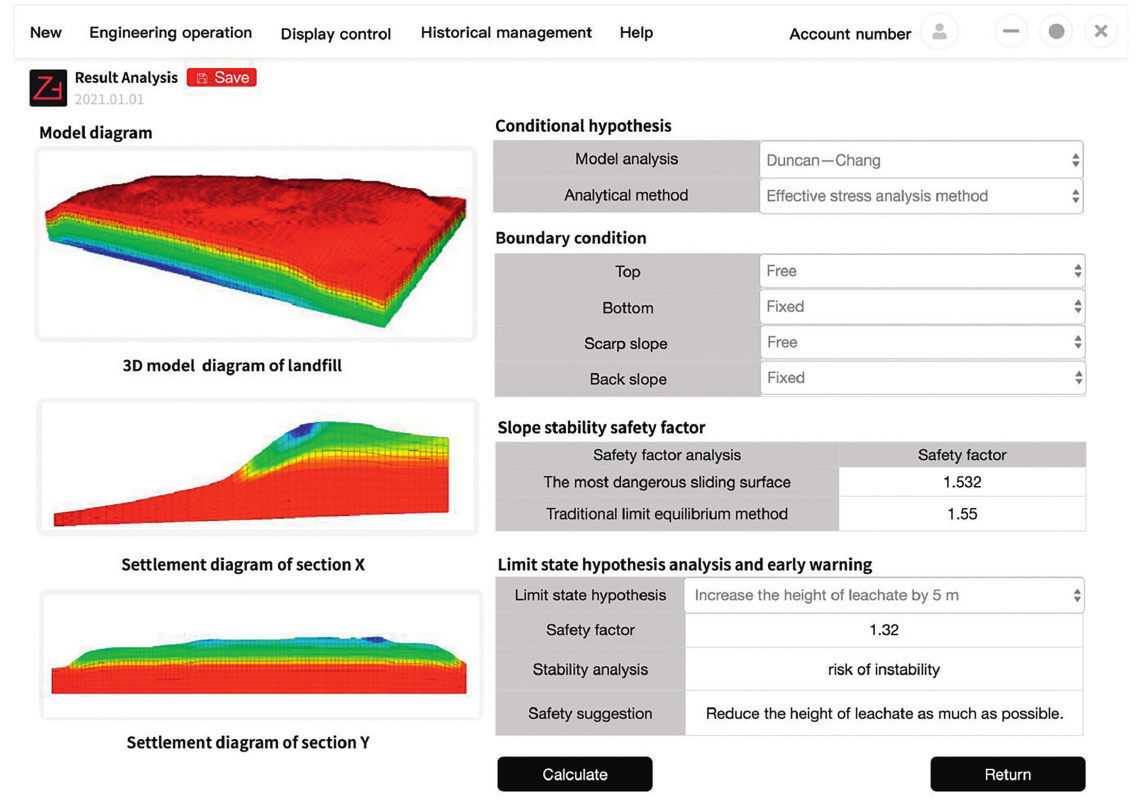
Figure 7: Result analysis. Table 1: Mechanical biological treatment (MBT) platform comparison and